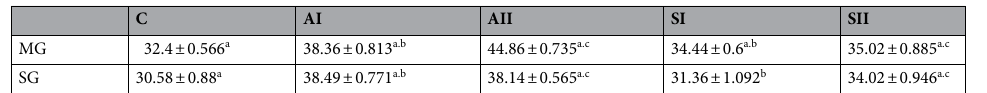
Table 1. The number of neurons positive for a neuronal isoform of nitric oxide synthase (nNOS) in the MG (myenteric plexus) and SG (submucous plexus) in the control group (C) and all of the experimental groups (AI, AII, SI, SII). Statistically significant (p ≤ 0.05) differences between group C and every experimental group were marked with a , between the AI group and SI group were marked with b , and between the AII group and SII group were marked with c